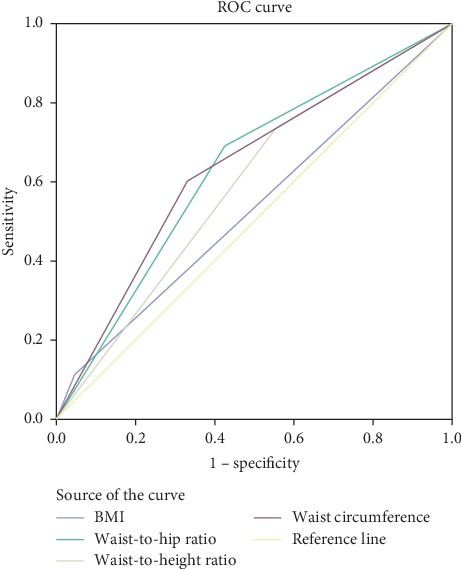
Receiver operating characteristic curve of body mass index (BMI), waist circumference (WC), waist-hip ratio (WHR), waist-to-height ratio (WHtR), and waist-to-square height ratio (WHt2R) to prediabetes in female.